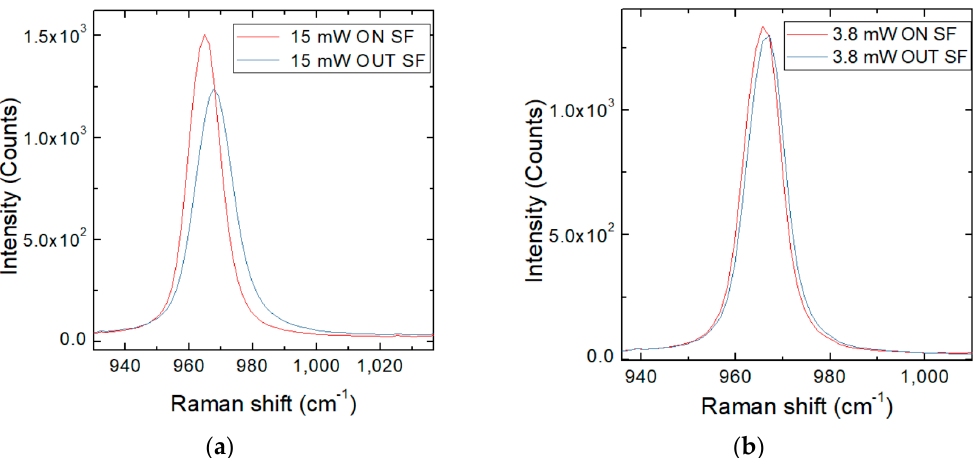
Figure 7. The figure shows LO Raman Shift on, and in proximity of, isolated SF defect at 430 nm (2.88 eV) with a laser power of 15 mW ( a ) and 3.8 mW ( b ) observing a reduction on shift.